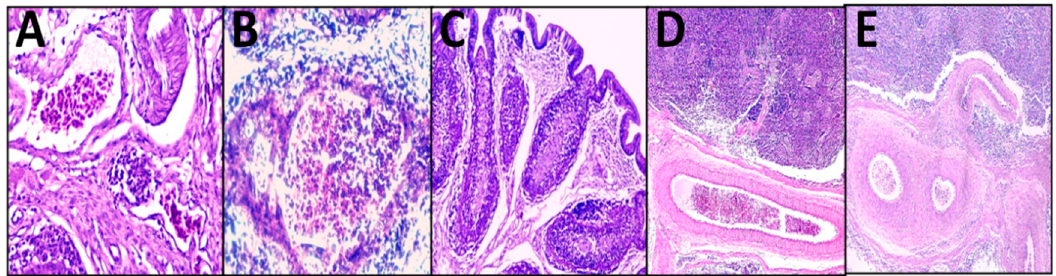
Figure 1. Histopathological lesions of bursae of fabricius ( A–C ) and spleen (D&E) (H&E): ( A ) Mild congestion of blood vessels (H&E × 400). ( B ) Interfollicular heterophils and macrophages aggregation (H&E × 400). ( C ) Interfollicular edema and necrosis of lymphocytic follicles replaced by heterophils and macrophages (H&E × 100). ( D ) Multifocal depletion of lymphocytes (H&E × 50). ( E ) Thickening of the wall of blood vessels (H&E × 100).